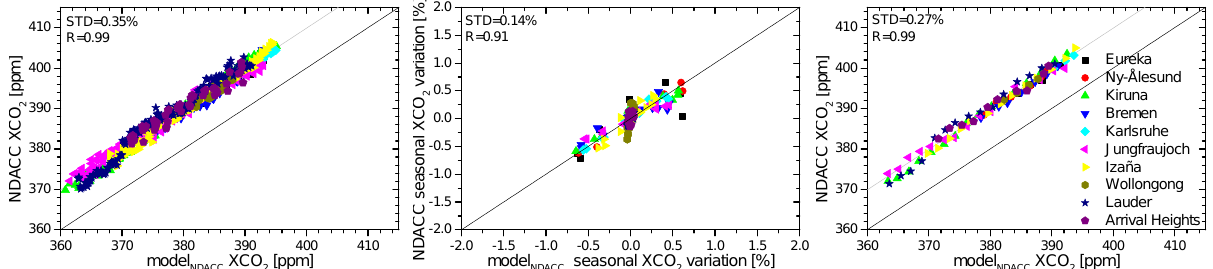
Figure 8. As Fig. 5 but for NDACC XCO 2 applying the WACCM fixed a priori and model NDACC and for the time period 1996–2012.